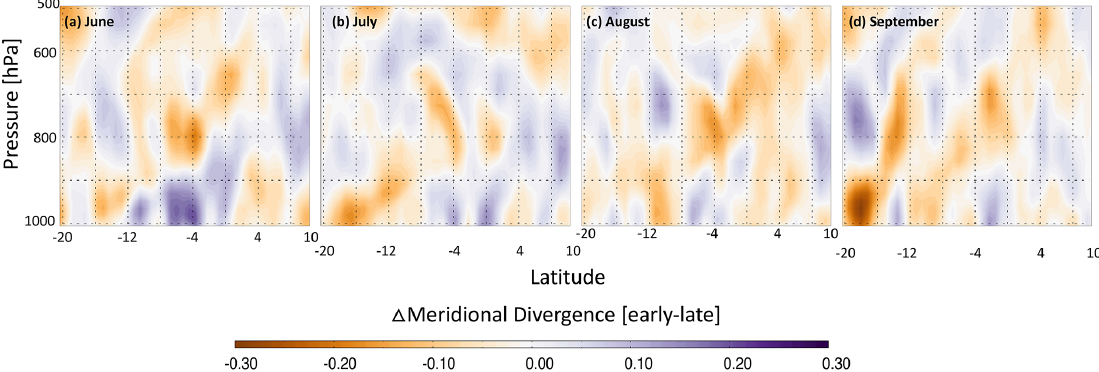
Figure 5. Differences in the mean meridional divergence between 10 ◦ N and 20 ◦ S between 1000 and 500hPa ( y axis) averaged over 12– 32 ◦ E, between the early- and late-onset years during (a) 30th–36th pentads (June), (b) 36th–42nd pentads (July), (c) 42nd–48th pentads (August), and (d) 48th–54th pentads